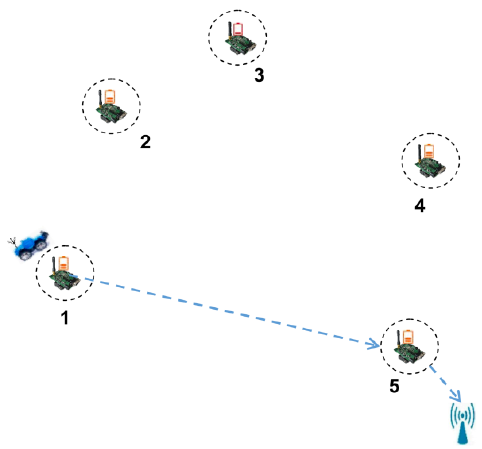
Figure 22. An example about the next recharging node selection strategy of ESAOC.